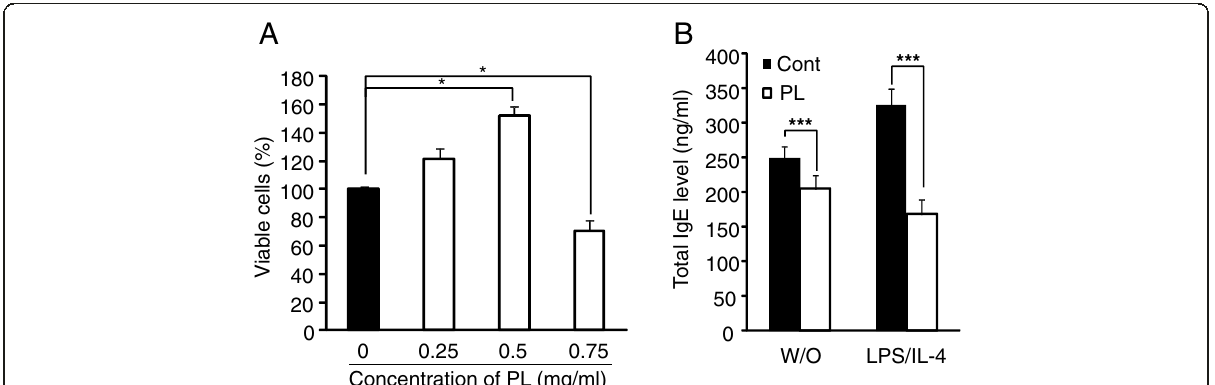
Figure 1 Treatment of P. linteus inhibits IgE production in B cell line. ( A ) Various concentrations of P. linteus extract were treated to U266B1 cell lines for 72 hrs and cell viability was measured by MTT assay. ( B ) U266B1 cells were stimulated with P. linteus (0.5 mg/ml) in the presence or absence of LPS (10 μ g/ml), IL-4 (5 ng/ml) for 72 hrs and IgE levels in the culture supernatants were determined by ELISA. Error bars indicated S.D. One (*), two (**) and three asterisk (***) indicates P<0.05, P<0.005, P<0.001, respectively. Data are representative of three independent